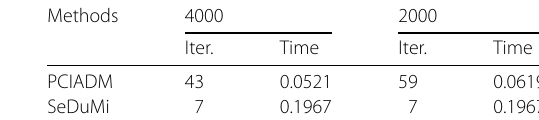
Table 2 The test results for the multiple force optimization problems Methods